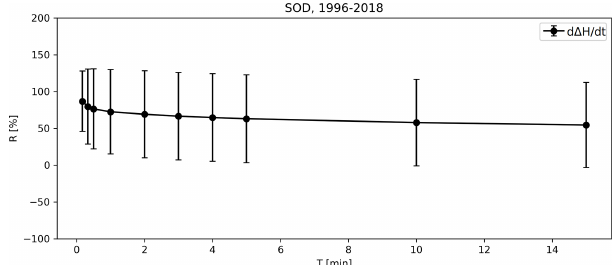
Figure 15. Mean values (black markers) and standard deviation (bars) of relative change in amplitude, R ( T ), of total d (cid:49) H / d t at SOD. Data from 1996–2018 and T = 10s, ...15min.